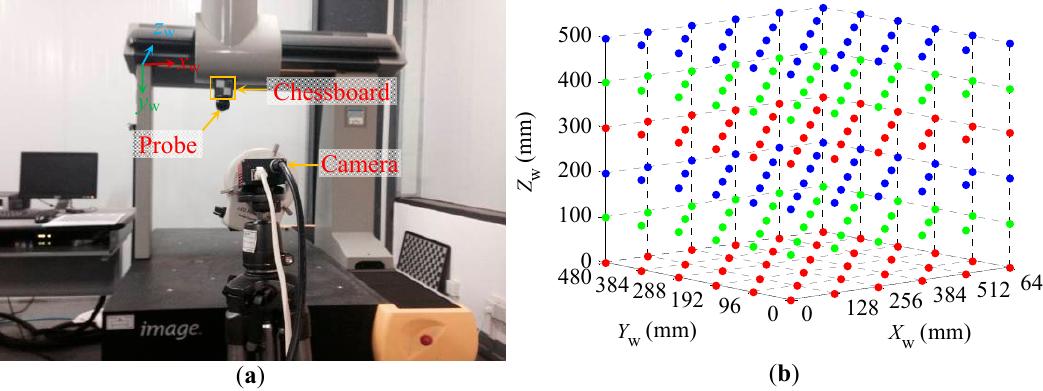
Figure 10. Camera calibration using ( a ) single chessboard and CMM for achieving ( b ) 3-D control points with specially designed positions.